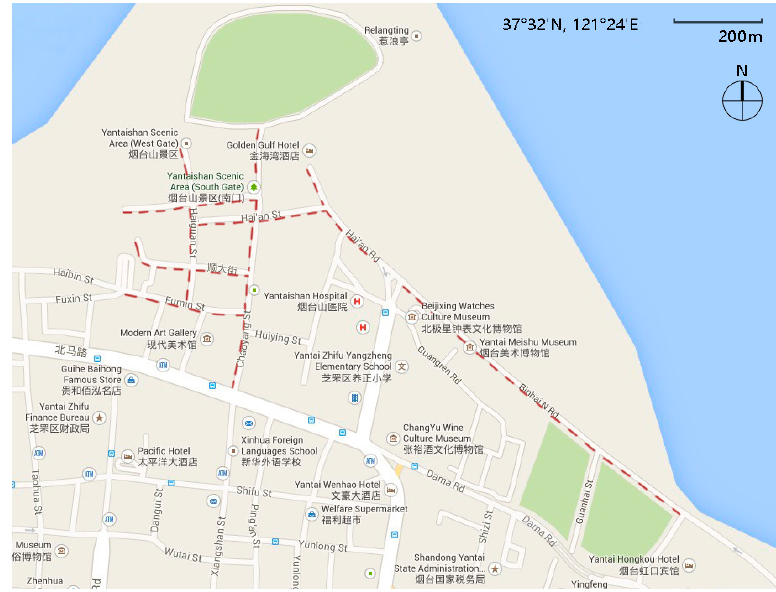
Figure 2. Study site: the Yantai Hill area.